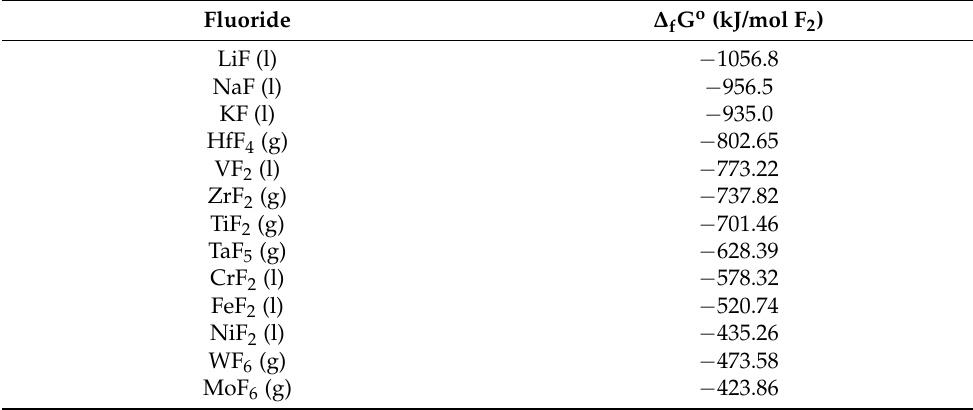
Table 4. Gibbs free energy of formation ( ∆ f G o ) of metal fluorides and potential corrosion products per mol of F 2 evaluated at 650 ◦